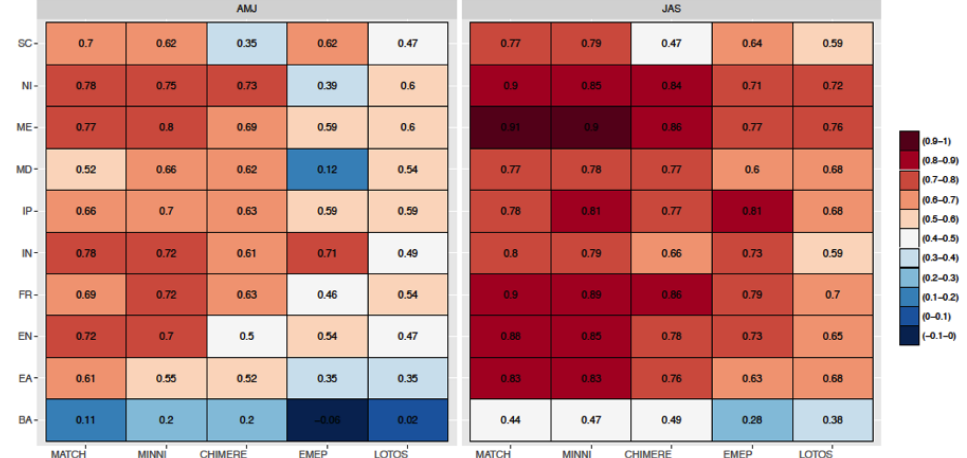
Figure 3. Correlation coefficients between observed and modelled MDA8 O 3 for spring (AMJ) and summer (JAS) for the period of study (2000–2010) at each region (rows) and model (columns, ordered by highest correlation values).